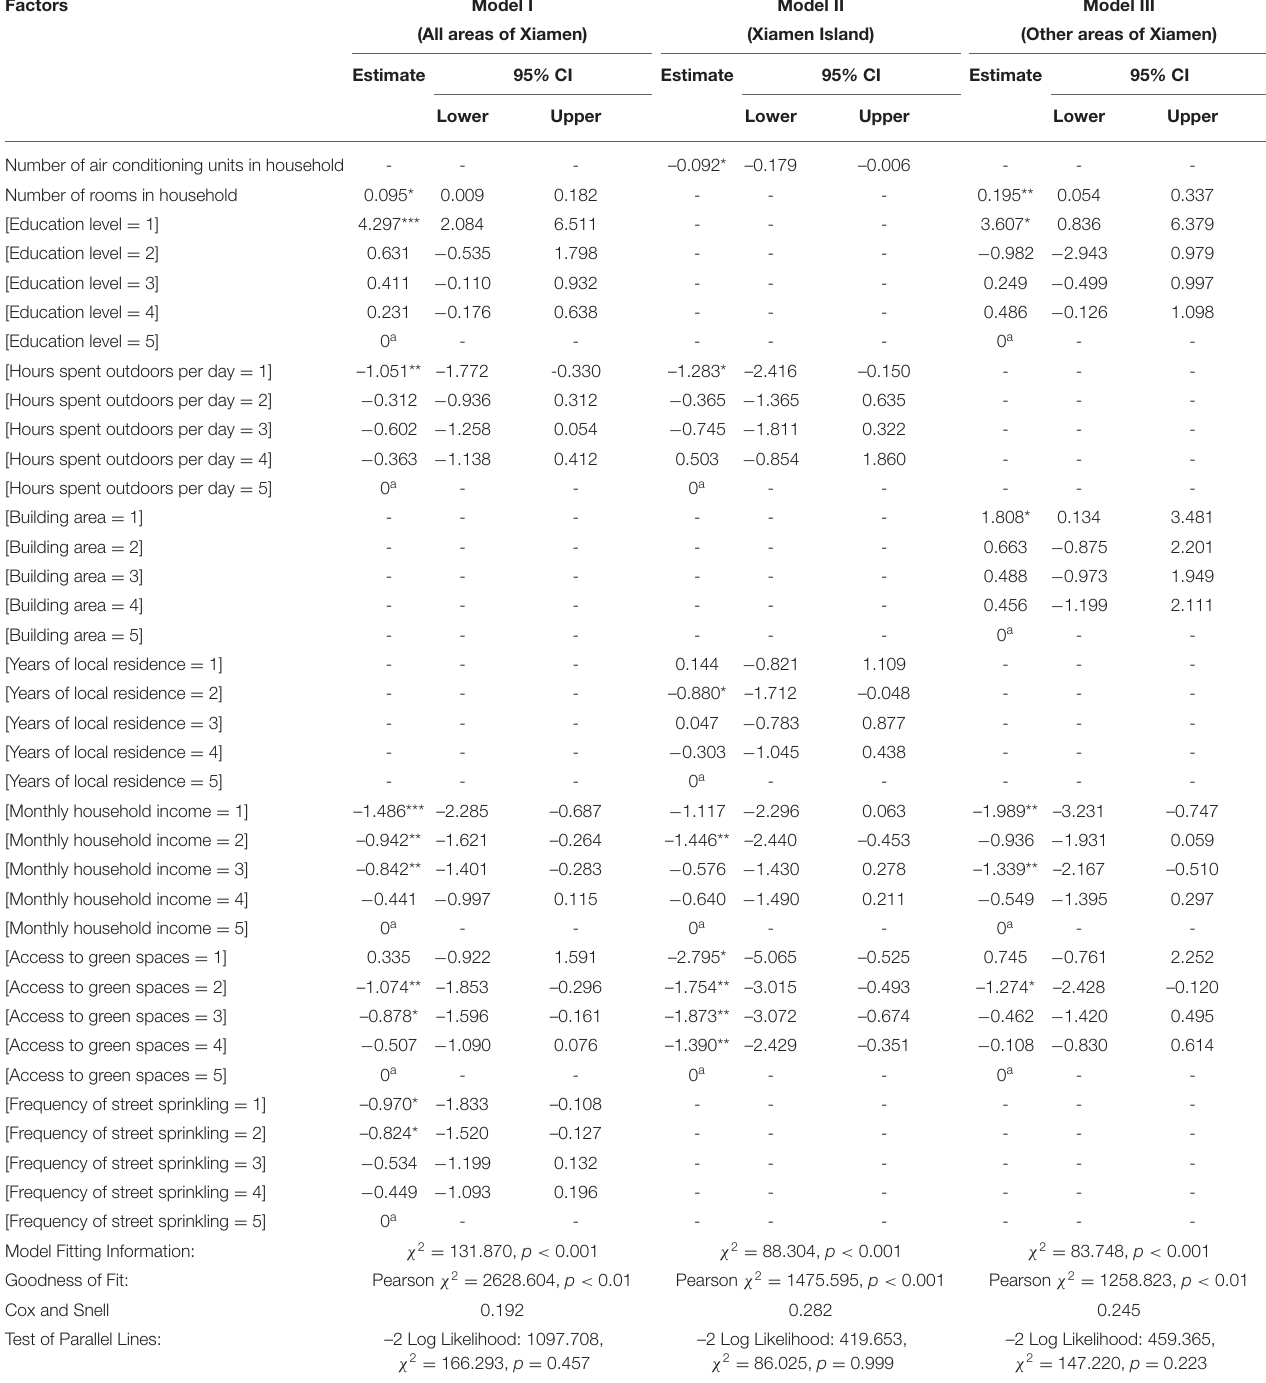
TABLE 2 | Factors significantly influencing residents’ HAC based on results of ordinal logistic regression.